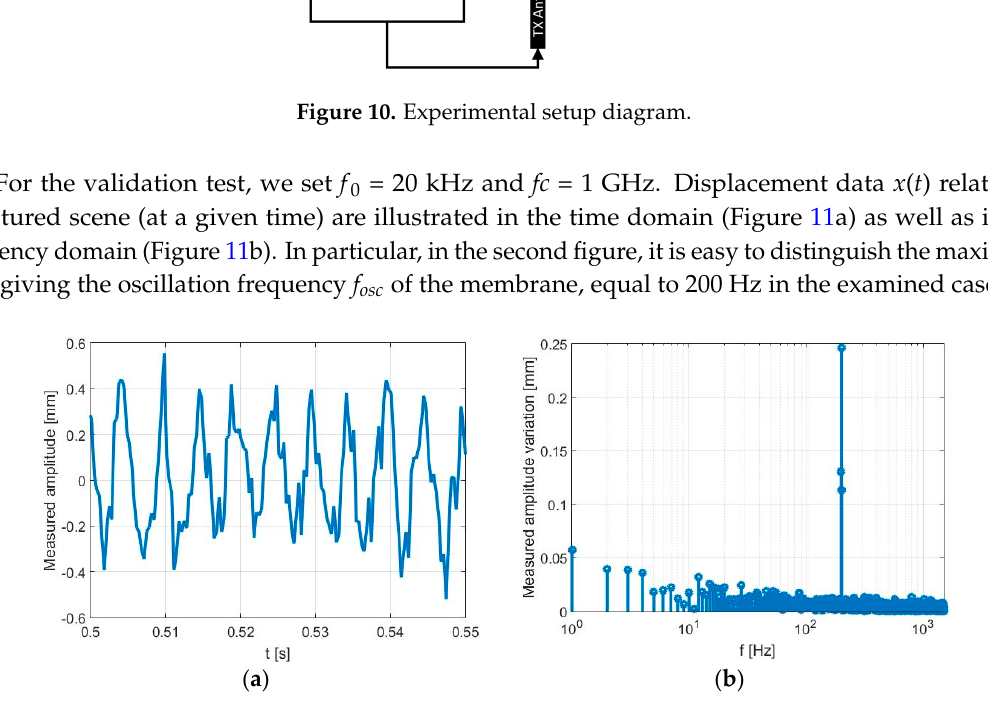
Figure 10. Experimental setup diagram.